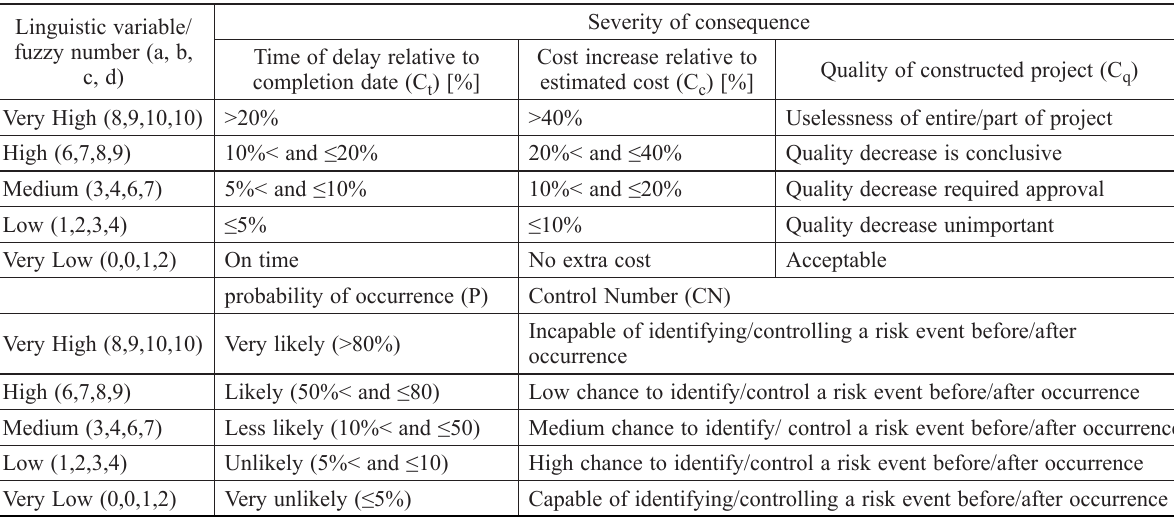
Table 2. Linguistic variables of risk components Linguistic variable/ fuzzy number (a, b, c,